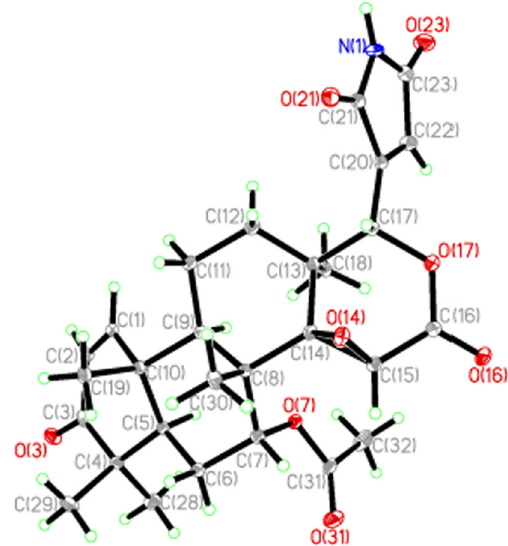
Fig. 3 X-ray structure of 1